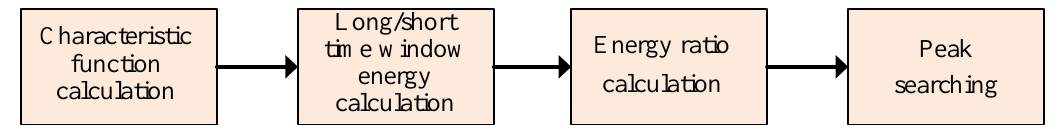
Figure 10. Flowchart of arrival time extraction.